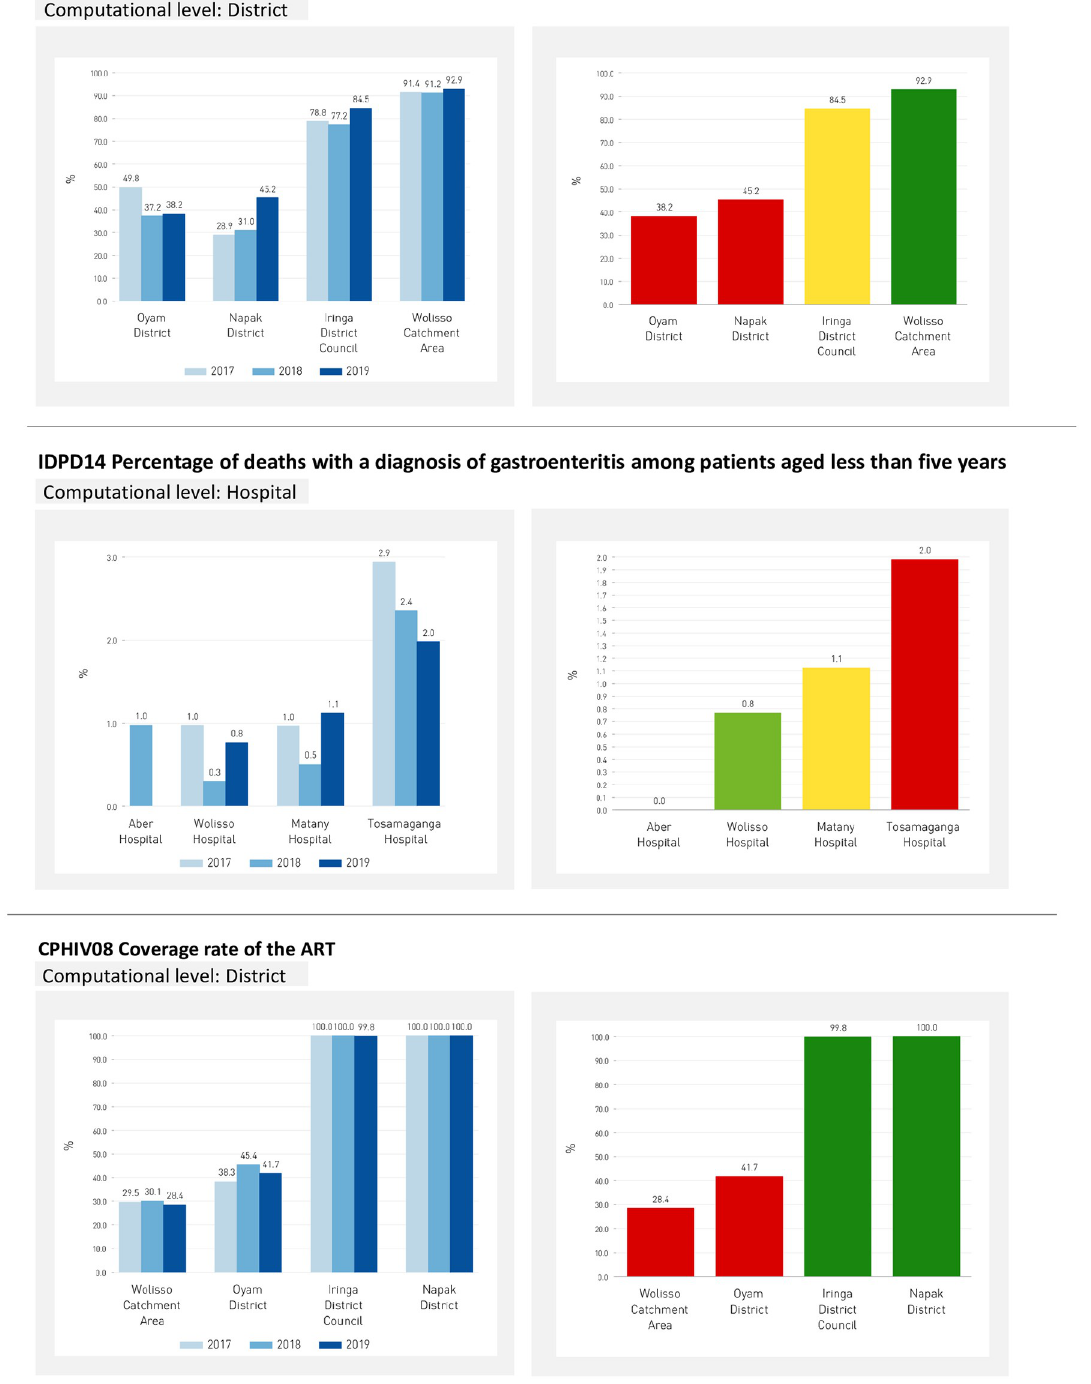
Fig 5. One selected indicator per each stave. Three-year trend indicators (panels on the left), and their respective evaluated scores for 2019 (panel on the right), one for each CD pathway.